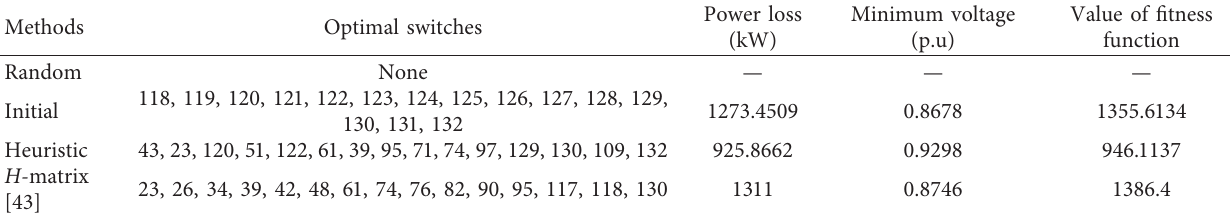
Table 7: The initial solution attached to the initial population for the 119-node